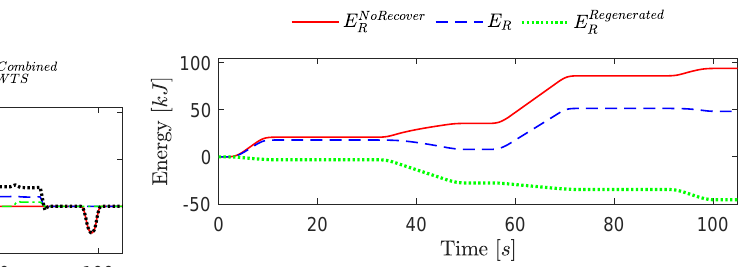
Figure 21: Energy consumption of the reach arm actuators.